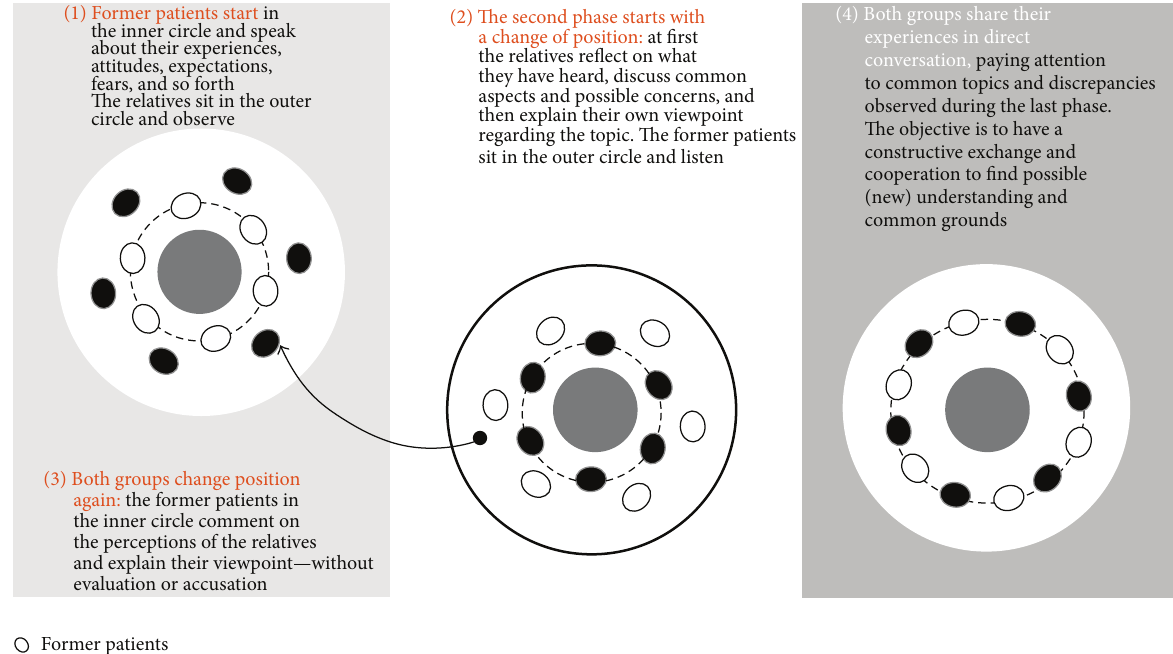
Figure 1: Outline of the T-group process used in the qualitative